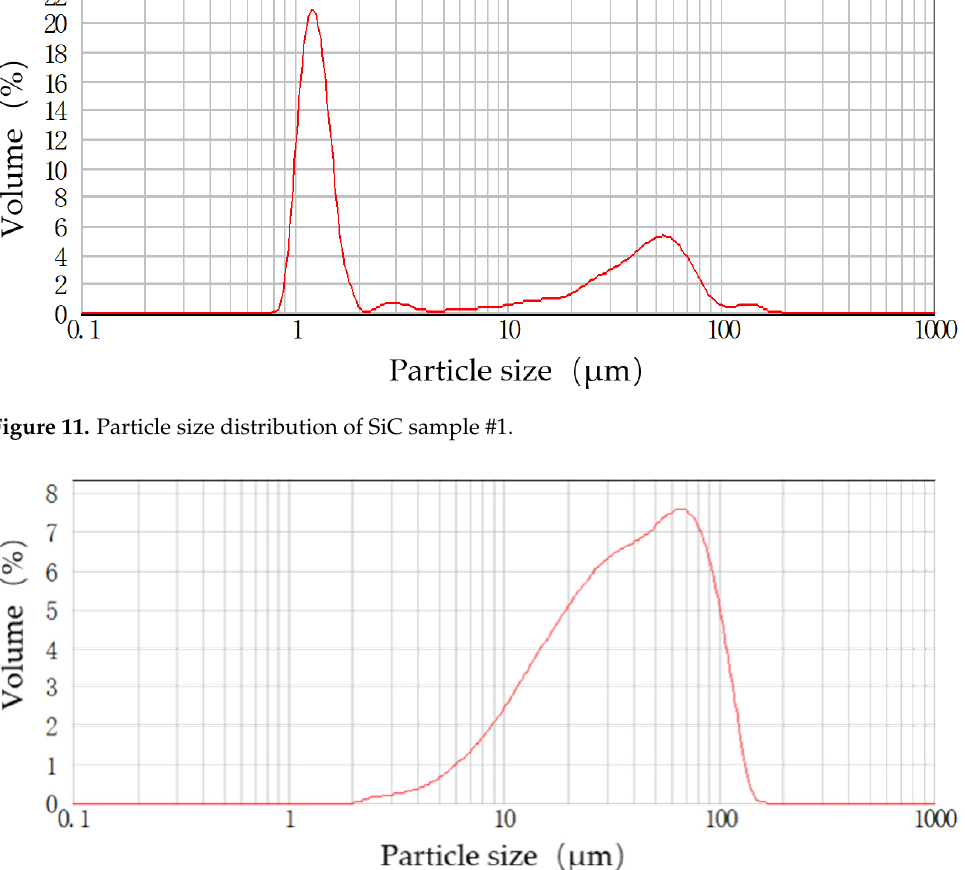
Figure 12. Particle size distribution of SiC sample